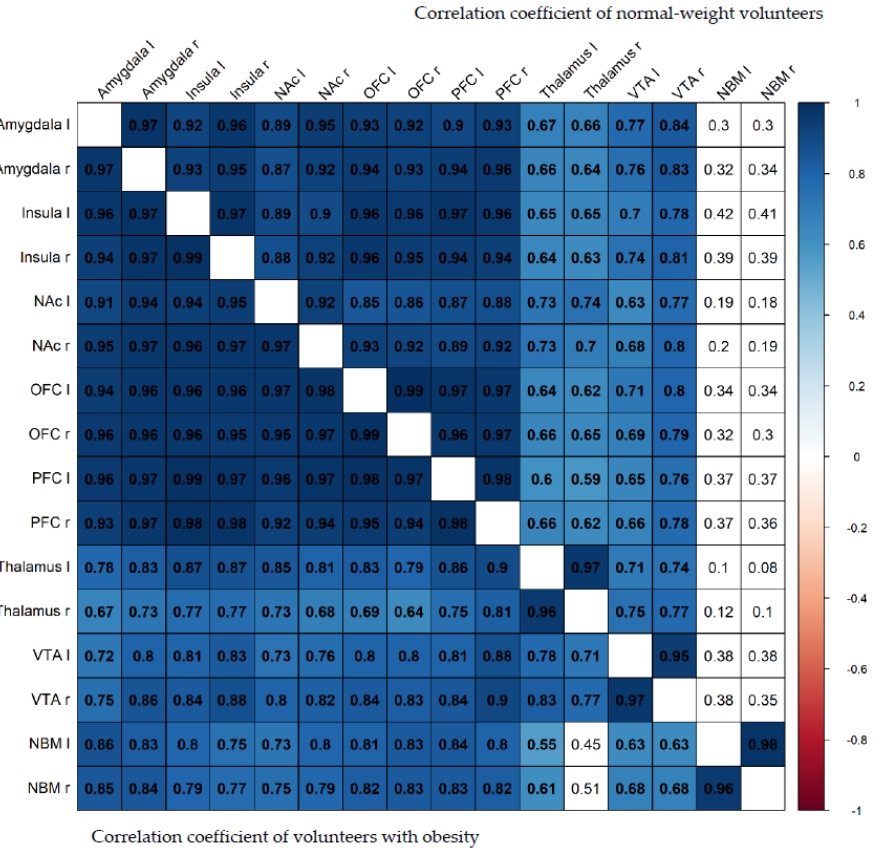
Figure 5. Correlation heatmap showing the strength of correlations between all volumes of interest, while blue indicates a positive correlation and red a negative correlation ( p < 0.05). Fields with a white background represent non-significant correlations ( p > 0.05). A partial correlation of V T with subscales of the TFEQ performed separately for individuals with obesity and normal-weight controls showed that none of the TFEQ subscales correlated significantly with V T (Table 3).